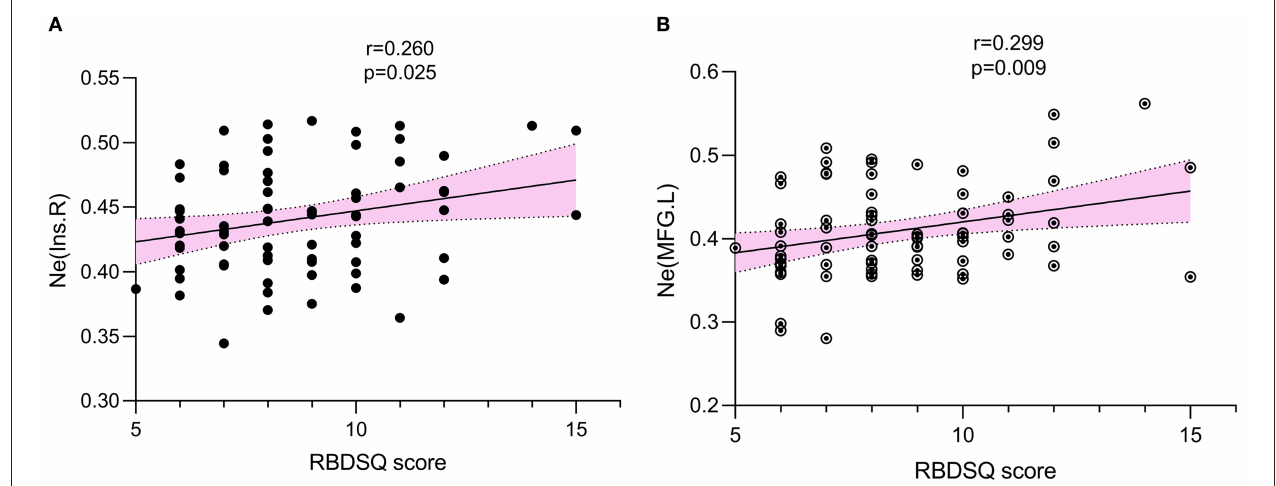
FIGURE 4 | The association was explored by multiple linear regression. p < 0.05 was set significant. RBDSQ scores were positively associated with Ne of right insula ( r = 0.260, p = 0.025) (A) , Ne of left middle frontal gyrus ( r = 0.299, p = 0.009) (B) . Ne, nodal efficiency; RBDSQ, rapid eye movement sleep behavior disorder screening